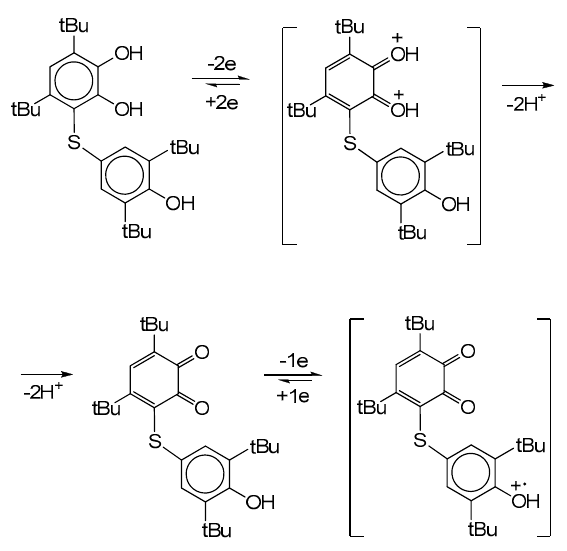
low stability of the electrically generated intermediates. The introduction of tert -butyl groups